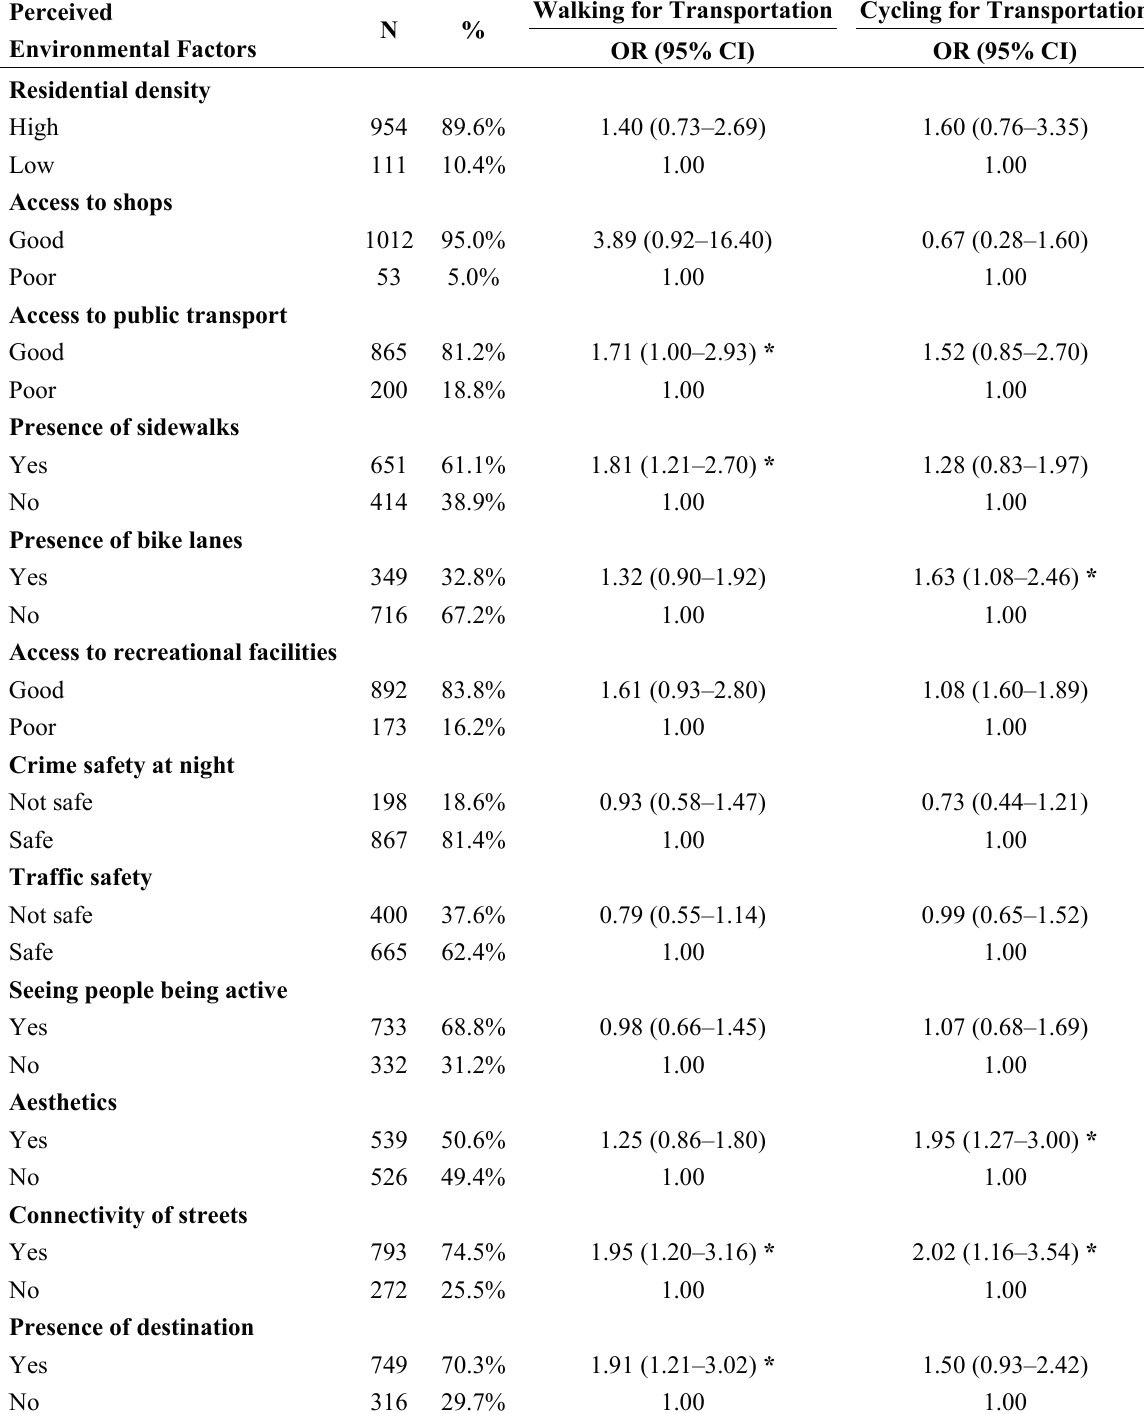
Table 3. Perceived environmental factors associated with walking and cycling for